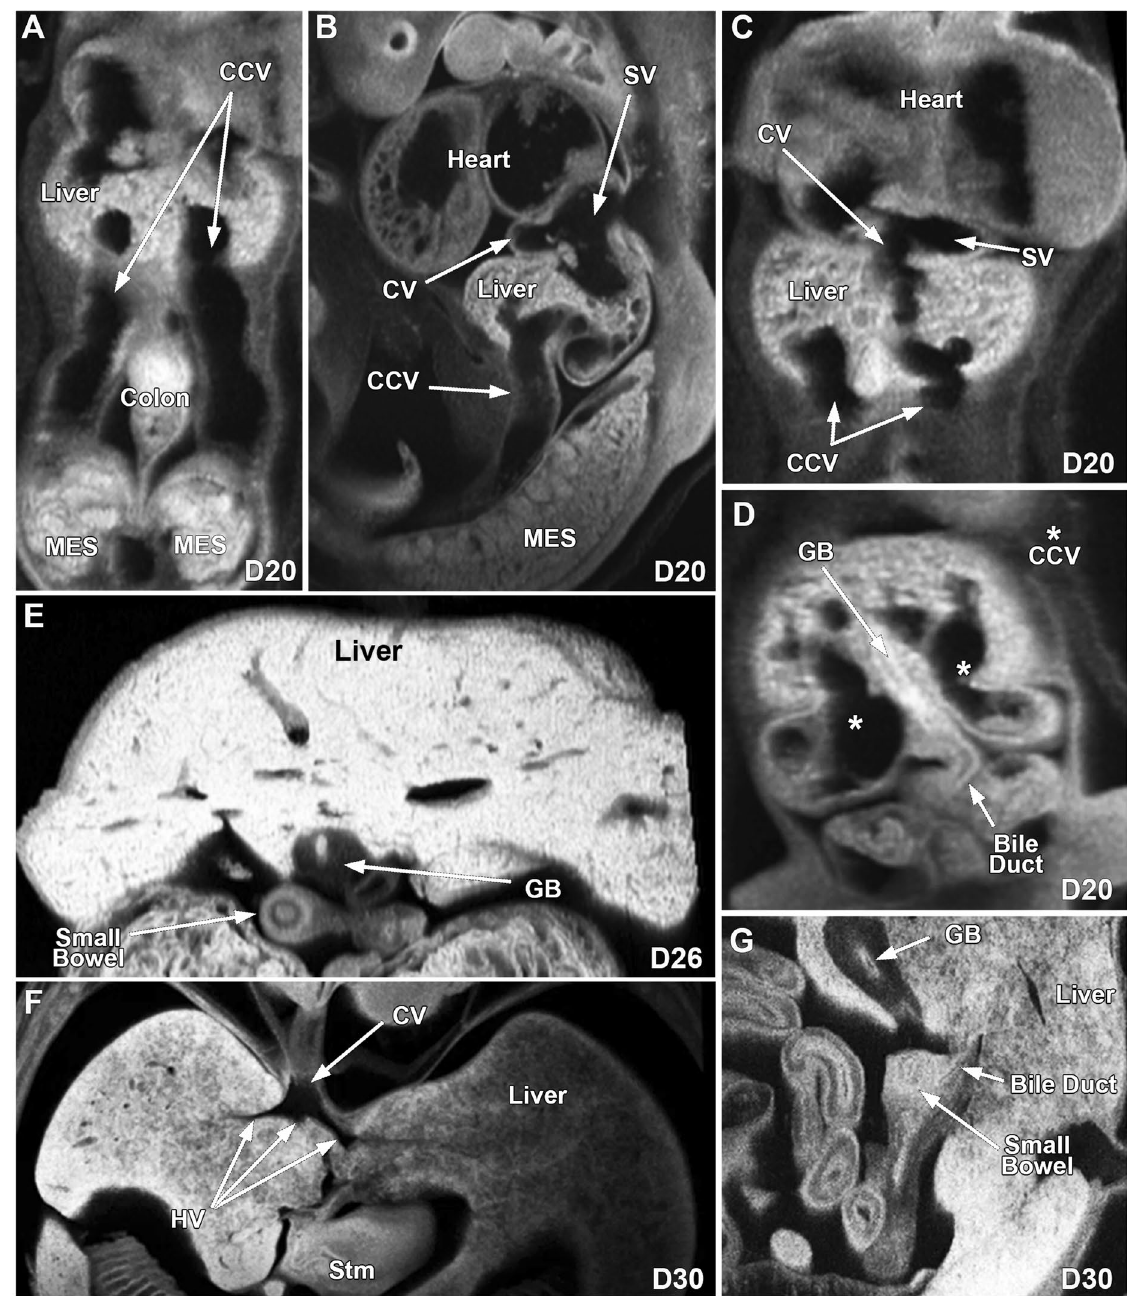
Figure 2. ECM imaging of developing caval veins, gallbladder, and liver in the pig at D20, D26 and D30. ( A ) shows the developing liver and caudal cardinal veins, ( B and C ) shows the supra-hepatic portion of the caval vein, sinus venosus and developing liver, and ( D ) shows the developing liver, gallbladder, and bile duct at D20. Image ( E ) shows the developing liver and gallbladder at D26. Illustration ( F ) shows the supra-hepatic caval vein and hepatic veins, and ( G ) shows the gallbladder with the bile duct connected to the small bowel at D30. CCV- Caudal Cardinal vein, SV-Sinus venosus, CV-Cava vein, GB-Gallbladder, MES-Mesonephros, Stm-Stomach, HV-Hepatic